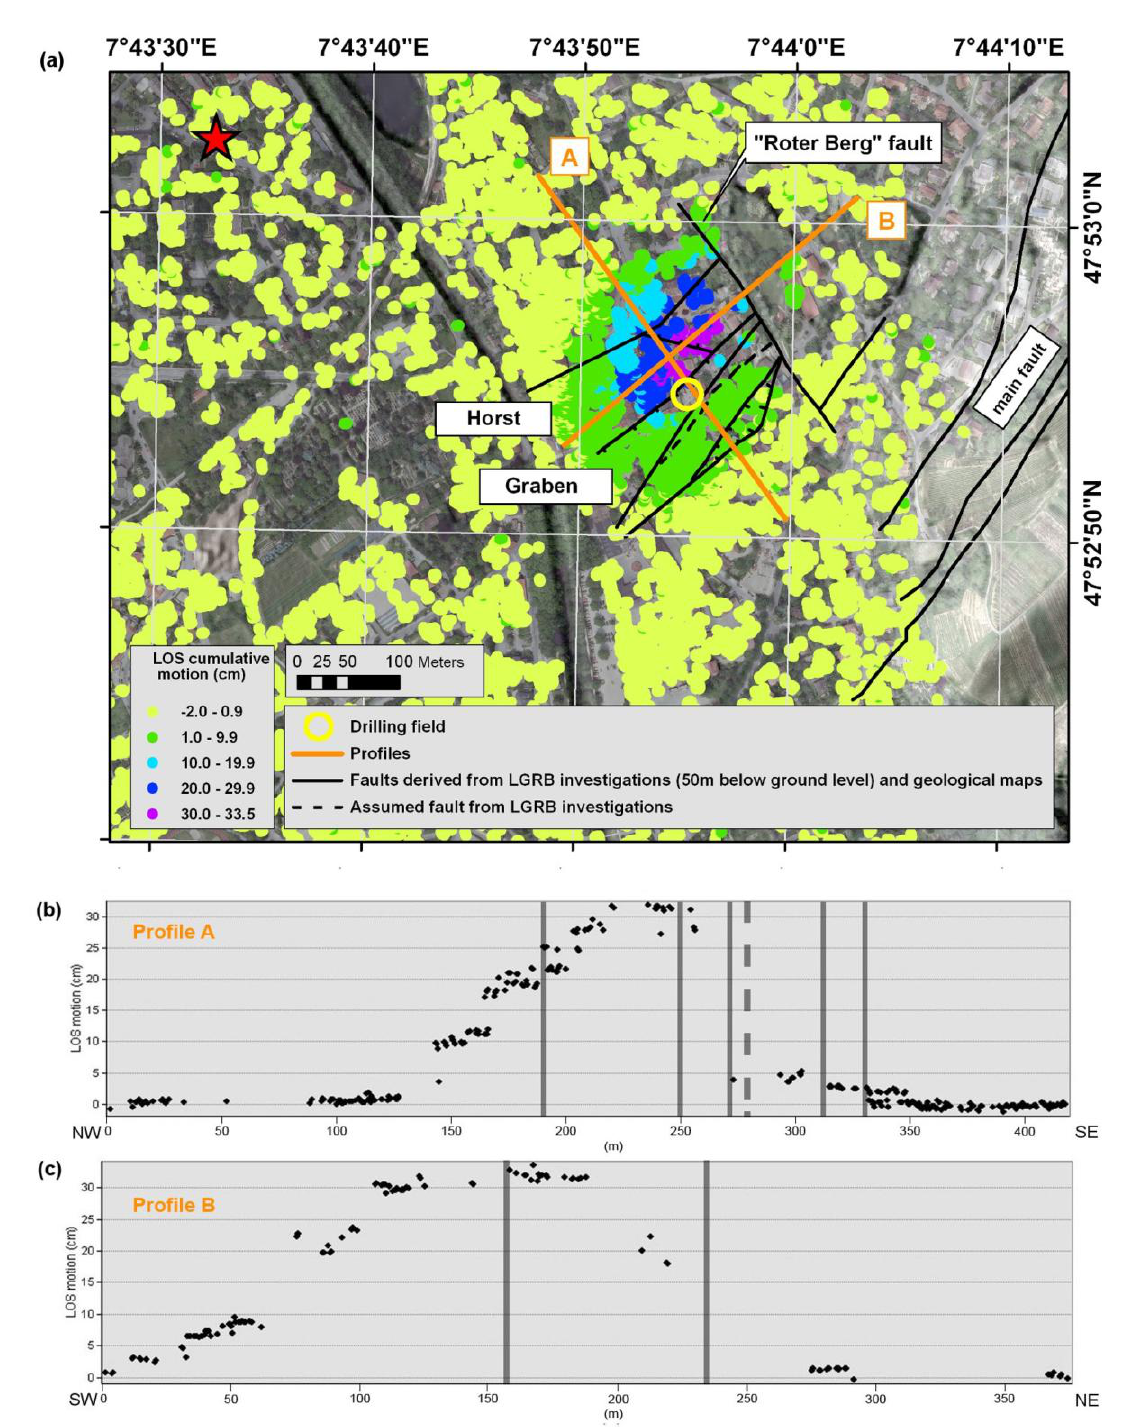
Figure 12. ( a ) SBAS-derived LOS displacement presented in five classes overlaid on geological structures [5]. The red star represents the reference point for the displacement, and the yellow circle shows the location of the drilling field. The locations of the two profiles as presented in (b) and (c) are highlighted with orange lines. ( b ) Cumulative LOS deformation along profile A. ( c ) Cumulative LOS deformation along profile B. The intersection of faults derived by the geophysical measurements of the LGRB with both profiles is shown by vertical